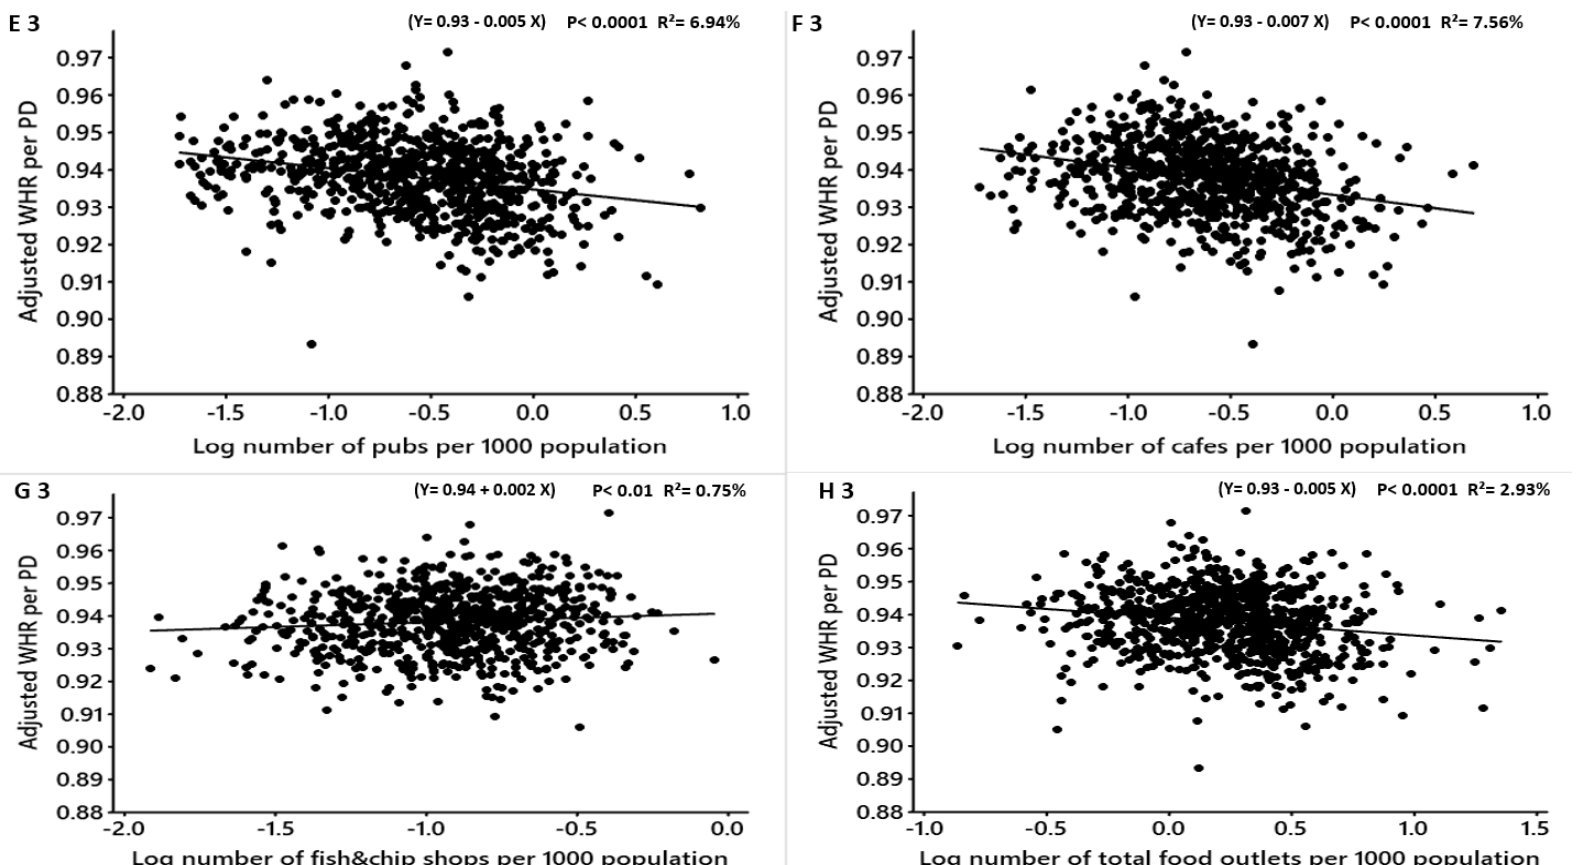
Figure 3. Males: Linear regression analysis of the association between log-transformed numbers of food outlets per 1000 population and adjusted obesity measures. Obesity measures adjusted for deprivation level per household, education, employment, ethnicity, household size, household income and age. BMI = Body Mass Index, WHR = Waist to Hip Ratio. FFR = Fast-Food Restaurants, FSR = Full-Service Restaurants, total food outlets = combined.